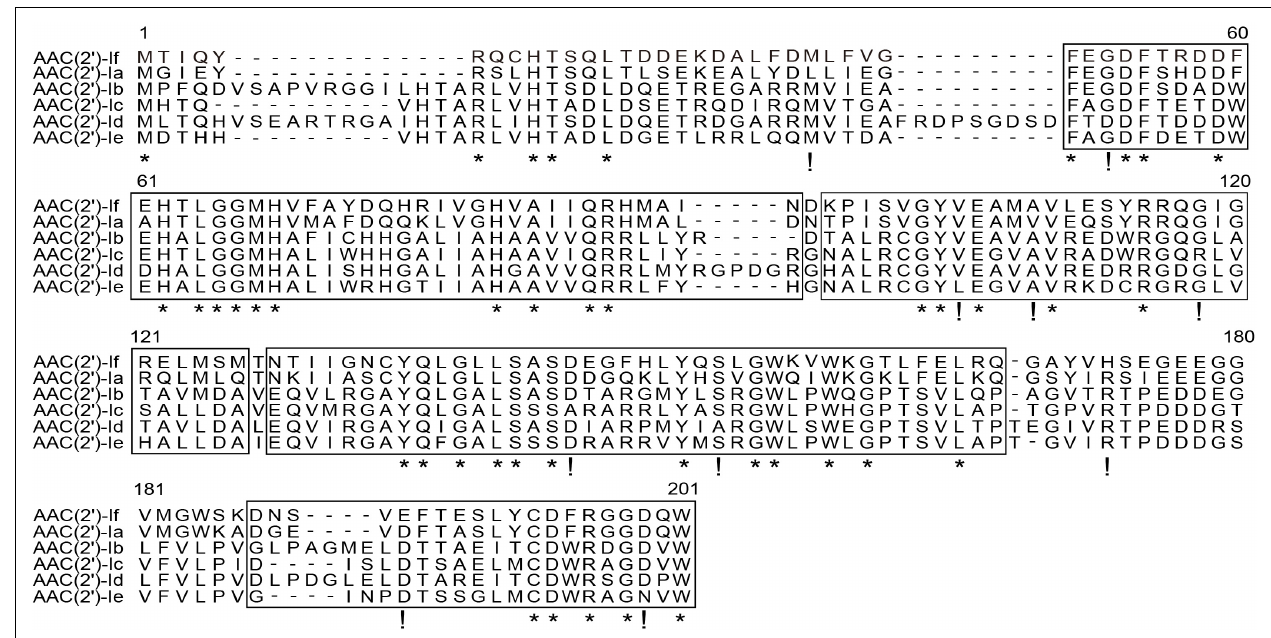
FIGURE 2 | Multiple sequence alignment of the amino acid sequences of the AAC(2 (cid:48) )-I subgroup. The sequences and their accession numbers are as follows: AAC(2 (cid:48) )-If (MW984427), AAC(2 (cid:48) )-Ia (AAA03550.1), AAC(2 (cid:48) )-Ib (AAC44793.1), AAC(2 (cid:48) )-Ic (AAB17563.1), AAC(2 (cid:48) )-Id (AAB41701.1), and AAC(2 (cid:48) )-Ie (CAR72650.1). The numbers on the right correspond to the amino acid residues in each full-length protein, with the conserved motif sites boxed, fully conserved residues shown with asterisks, and highly similar residues shown with exclamation marks.